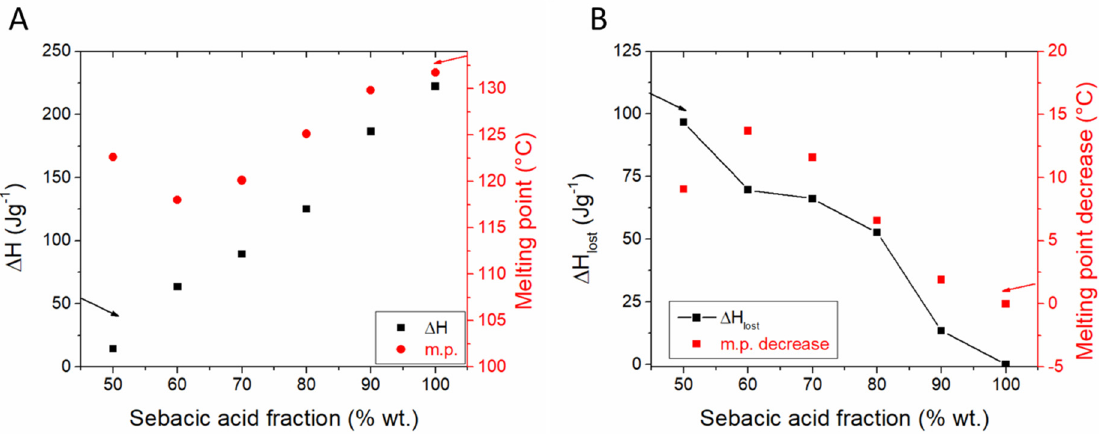
Figure 11. ( A ) The heat of fusion and m.p. and ( B ) lost enthalpy and m.p. decrease of sebacic acid-MCM-41 composite PCMs. Data from ref. [143].